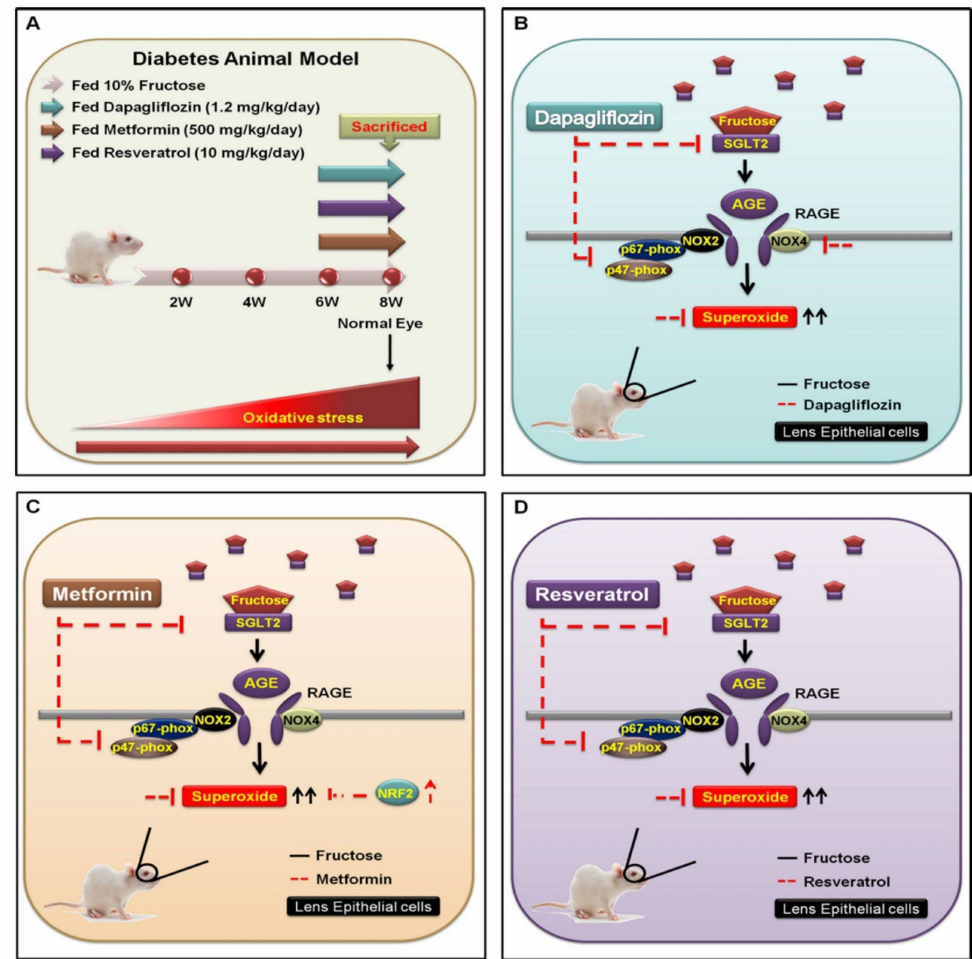
Figure 5. Underlying mechanism for inhibiting SGLT2 − enchanced NOX2/4-dependent oxidative stress in the lens of type 2 DM. ( A ) WKY rats were categorized into four experimental groups: (1) 10% fructose only for 6 weeks; (2) followed by oral administration of dapagliflozin (1.2 mg/kg/day); (3) metformin (500 mg/kg/day); and (4) resveratrol (10 mg/kg/day) for 8 weeks. ( B ) The SGLT2 inhibitor dapagliflozin is an important fructose regulator that downregulates the SGLT2 − induced ac- tivity of AGE − RAGE − NOX2/4 and p47 − phox (red line). ( C , D ) Fructose requires SGLT2 to increase superoxide generation (black line); however, both metformin and resveratrol prevent superoxide accumulation through reduction of fructose-activated SGLT2 signal transduction (red